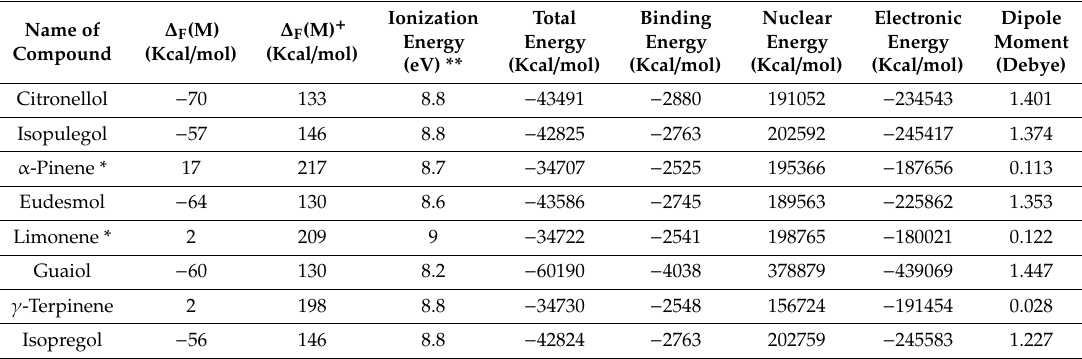
Table 5. Thermodynamic data of the studied molecules calculated within the modified neglect of diatomic overlap (MNDO)